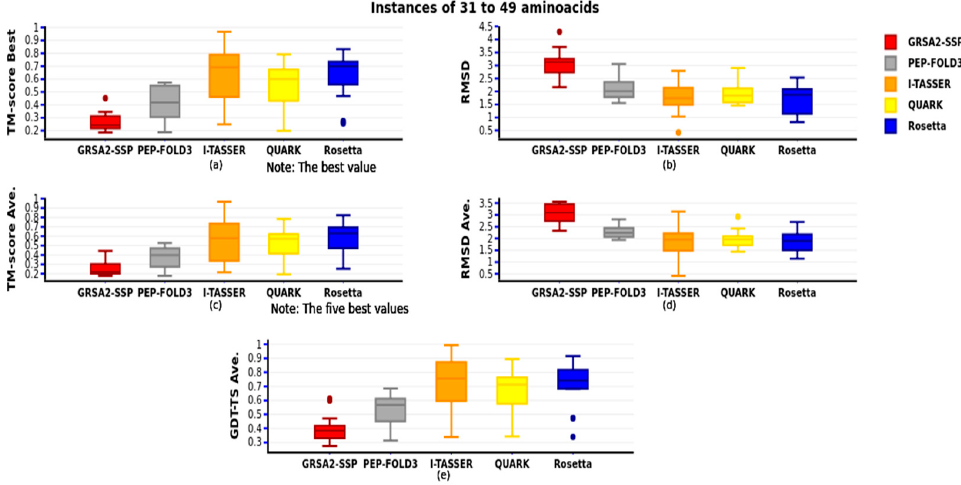
Figure 11. Comparison of GRSA2-SSP, PEP-FOLD3, I-TASSER, QUARK, and Rosetta by TM-Score (31 to 49 amino acids). Figure 11 ( a ) best TM-score, and ( b ) their RMSD, ( c ) TM-score average of the five best predictions, ( d ) RMSD average of the five best predictions, and ( e ) GDT-TS average of the five best predictions.